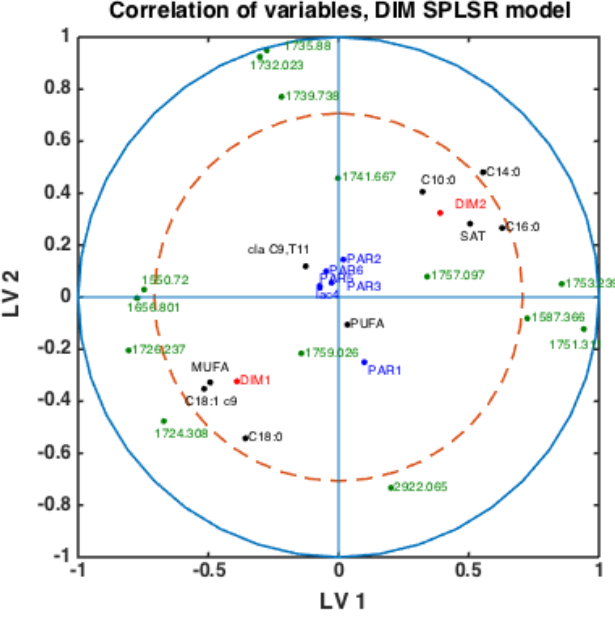
Figure 4. Correlation loading plot obtained from SPLSDA model for classification of FTIR spectra into the two main groups of DIM: DIM1: DIM ≤ 50; DIM2: 50 < DIM < 100 including all samples of all parities.